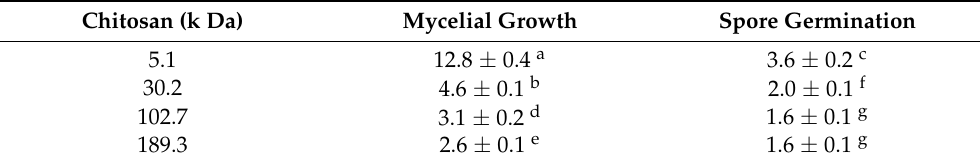
Table 1. The minimum inhibition concentration (MIC) (g/L) of chitosan with different molecular weights (Mw) against the mycelial growth and spore germination of Fusarium graminearum isolated from